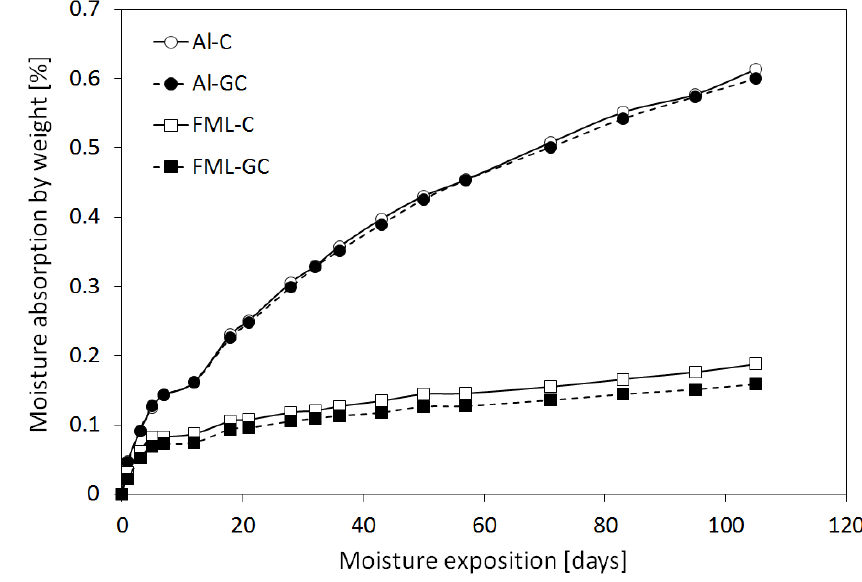
Figure 4. Moisture absorption of the materials studied.